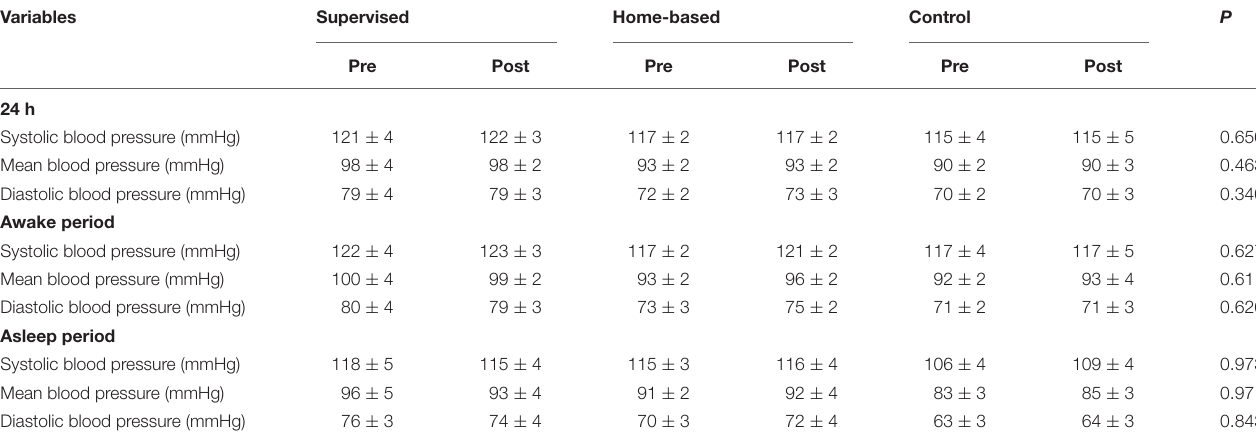
TABLE 2 | Effects of home-based and supervised isometric handgrip training and control on ambulatory blood pressure in hypertensives. Variables Supervised Home-based